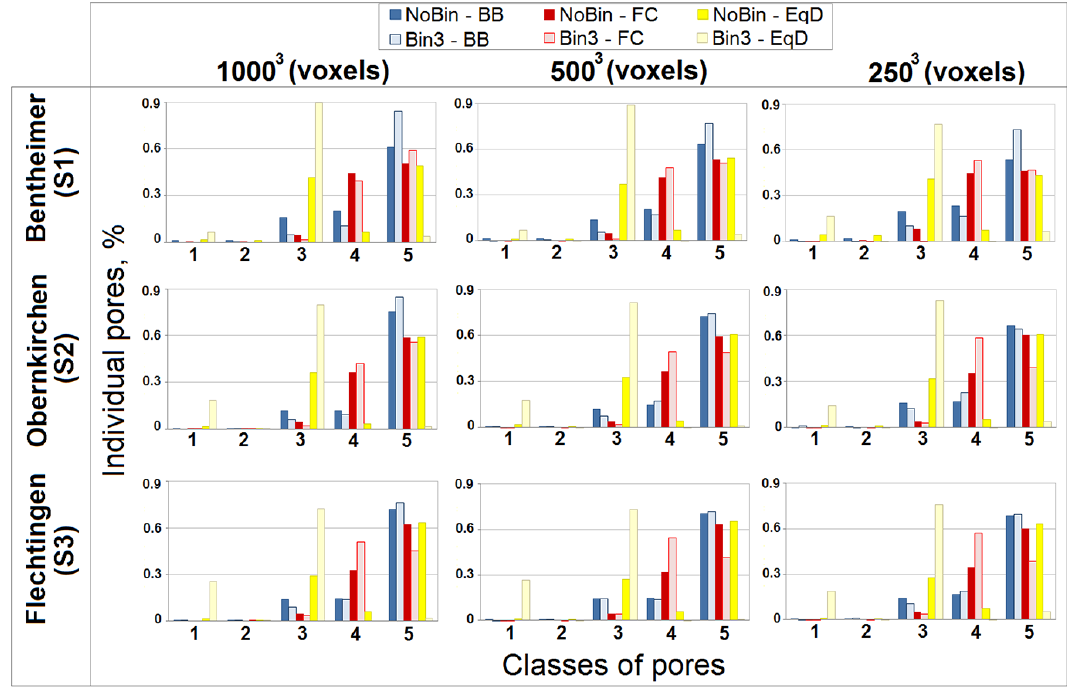
Figure 10. Effect of subsample volume size on the (1) rod-, (2) blade-, (3) cuboid-, (4) plate-, and (5) cube-shaped classes of the pore ganglia (NoBin) and the detached pore networks